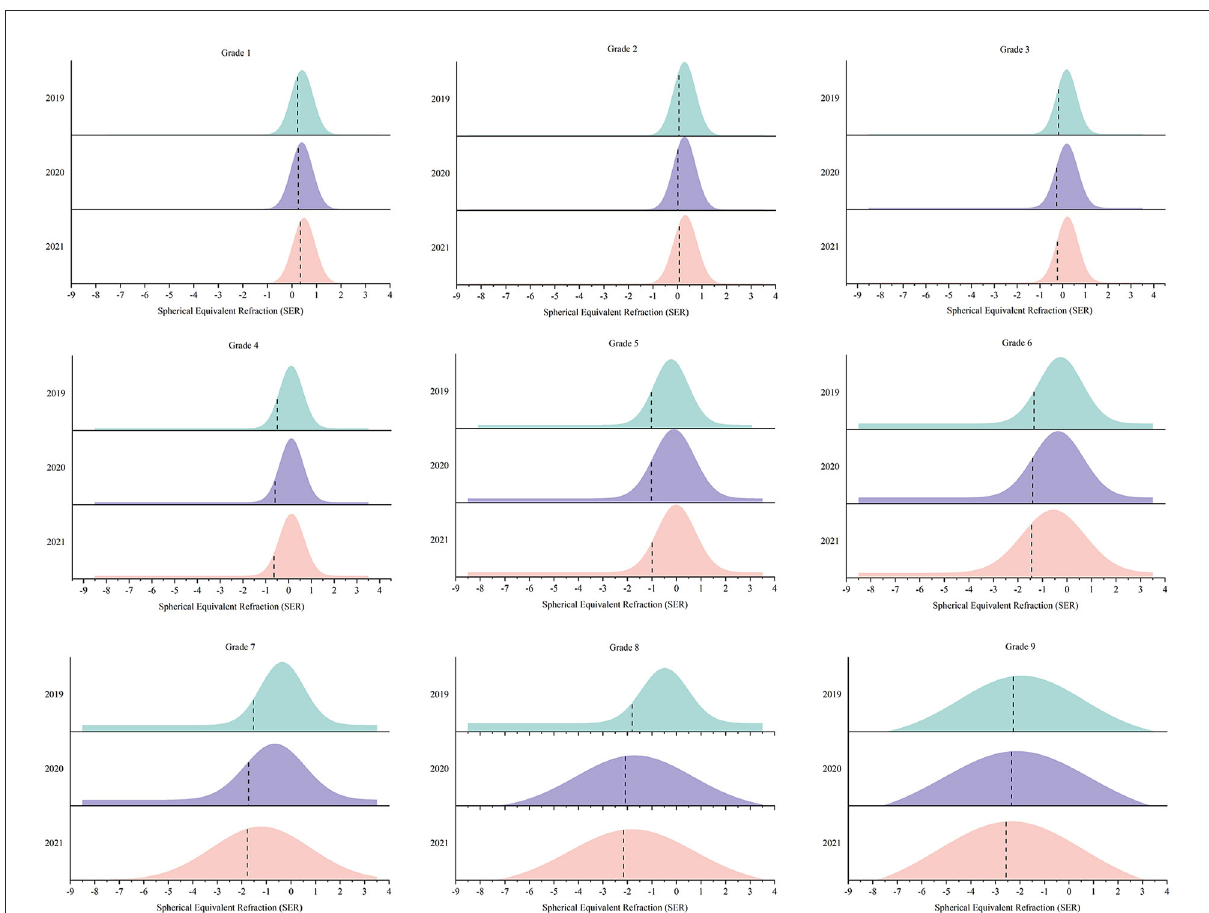
FIGURE1 The distribution of Spherical Equivalent Refraction (SER) from grades 1 to grade 9 over the 3